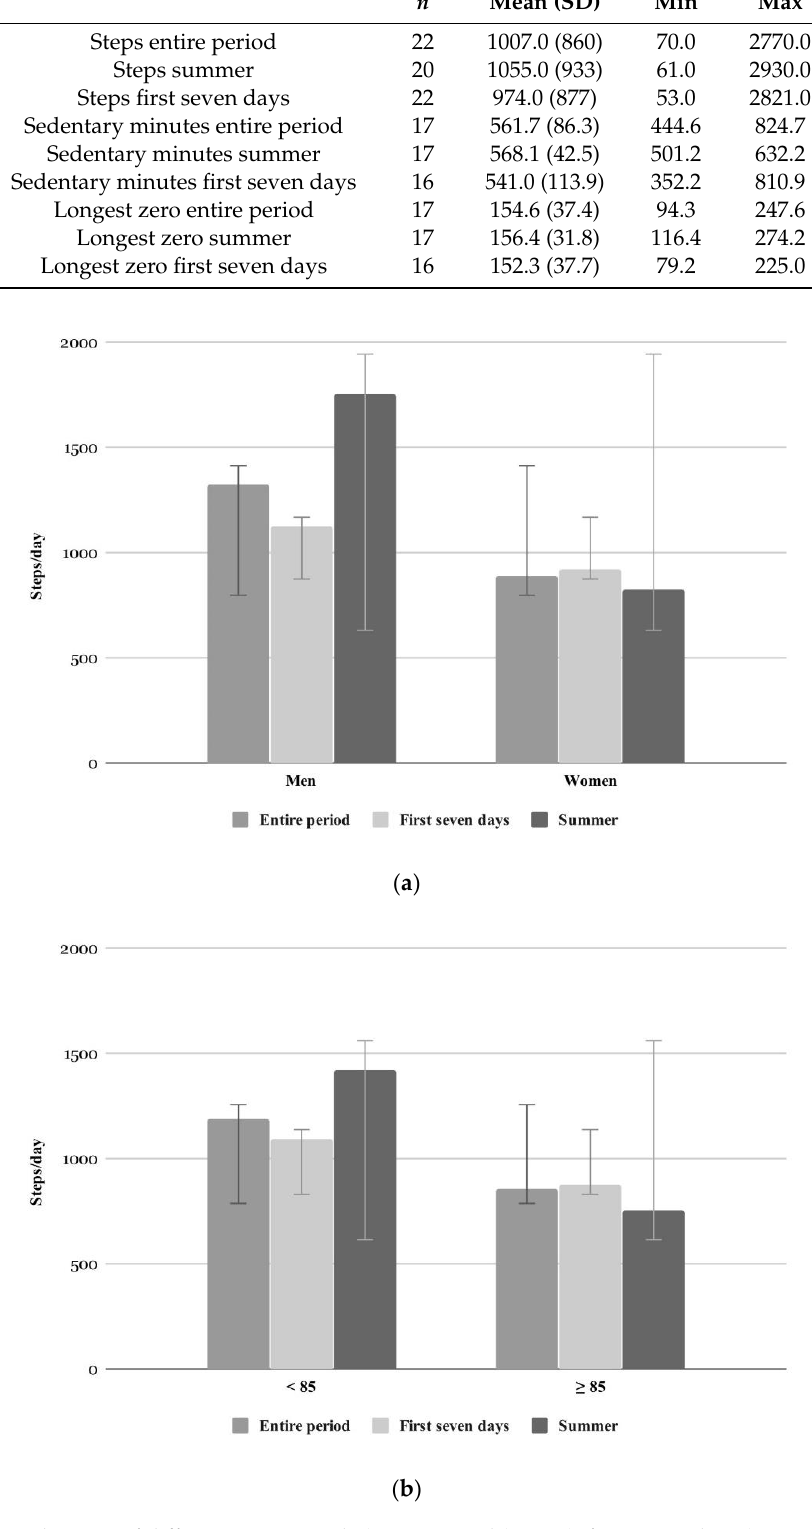
Figure 1. Daily steps of different time periods (entire period ( n = 22), first seven days ( n = 22), summer months ( n = 20)) separated by ( a ) gender and ( b ) age.